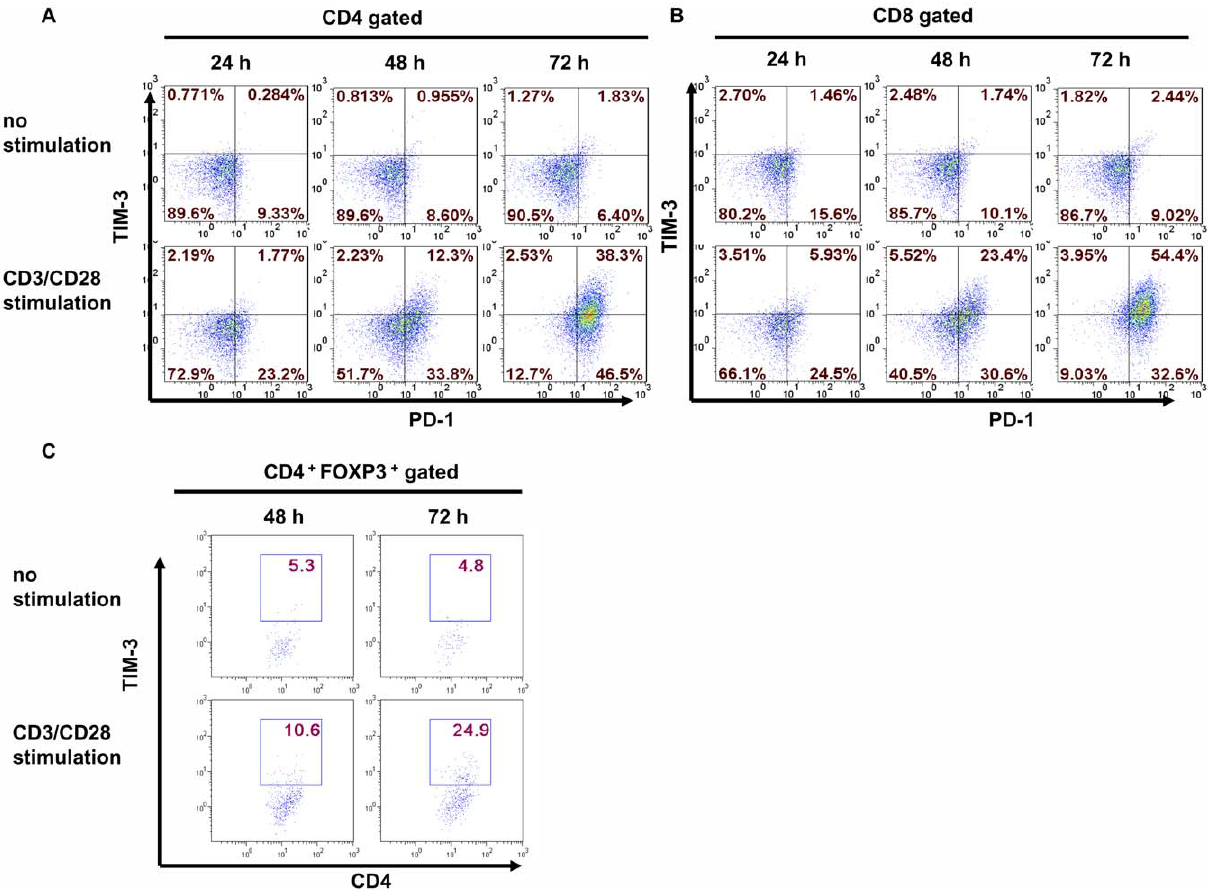
Figure 4. TIM-3 and PD-1 were up-regulated upon T cell activation. (A and B). Human naı¨ve T cells were purified from PBMCs of health donors. Cells were then stimulated with plate-bound anti-CD3 plus anti-CD28 mAb. 24, 48 and 72 hours later, cells were collected and stained for CD4, CD8, TIM-3 and PD-1. The expression of PD-1 and TIM-3 was analyzed by flow cytometry on gated CD4 + (A) or CD8 + (B) T cells. C. CD4 + CD25 high T cells were isolated from peripheral blood by FACS. These cells were then stimulated with anti-CD3 and anti-CD28 in the presence of IL-2 (200 U/mL). 24, 48 and 72 hours later, cells were harvested and stained for CD4, TIM-3 and FOXP3. The expression of TIM-3 on CD4 + FOXP3 + T cells is shown. Data are representative of three independent experiments.